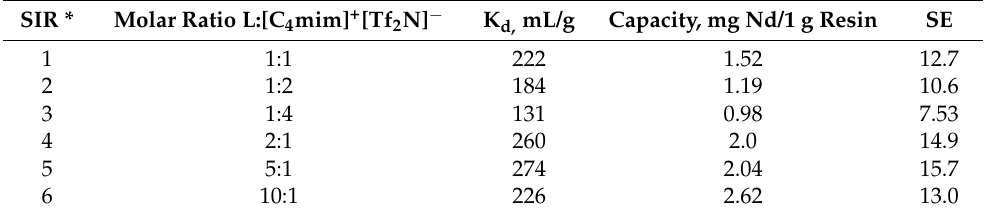
Table 2. The values of distribution coefficient (K d ), capacity and synergy effect (SE) obtained for SIRs of different composition in Nd(III) recovery from HNO 3 of 0.001 mol/L. SIR